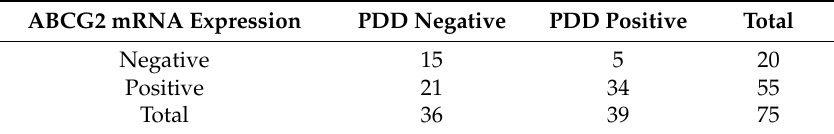
Table 2. Correlation between ABCG2 immunoreactivity and PDD in PM ( p = 0.0048) [20].